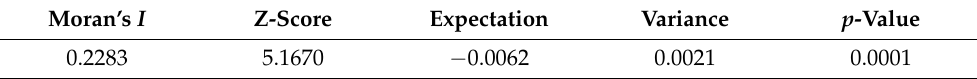
Table 2. Moran’s I